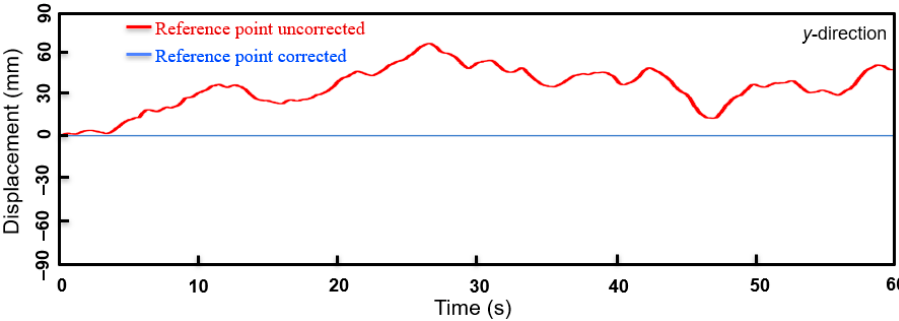
Figure 10. Six degrees of freedom motion of the UAV ( Z w = 0).